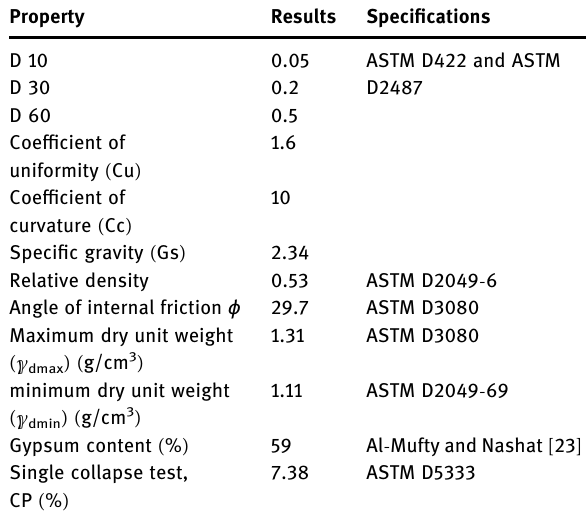
Table 3: Results of laboratory testing on gypseous